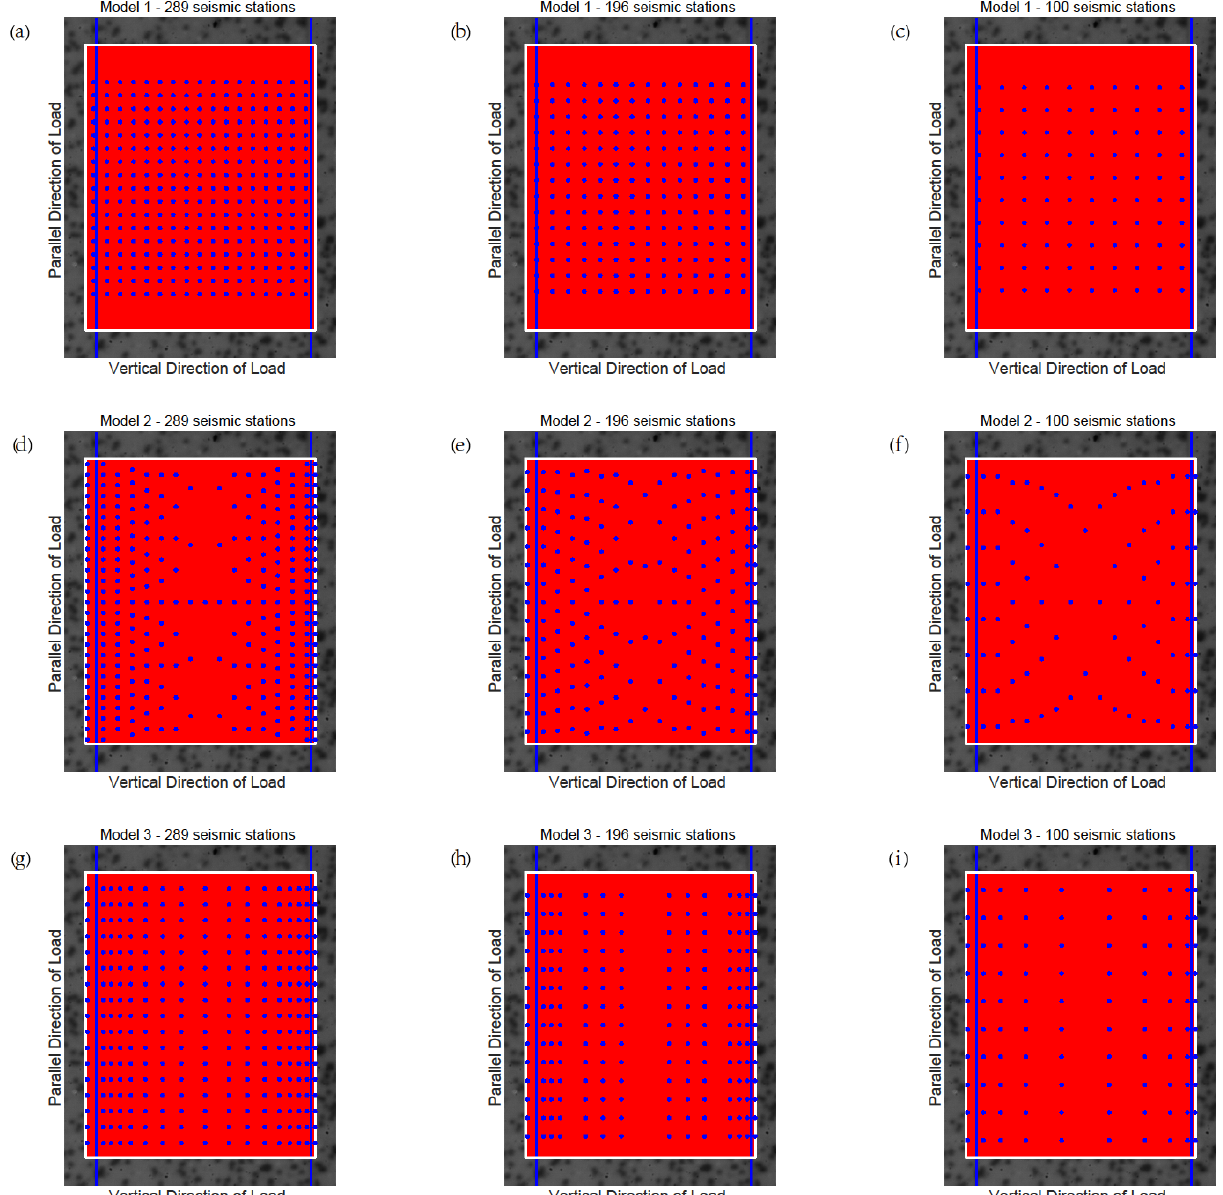
Figure C3. Three kinds of seismic monitoring models with different numbers of seismic monitoring stations for sample